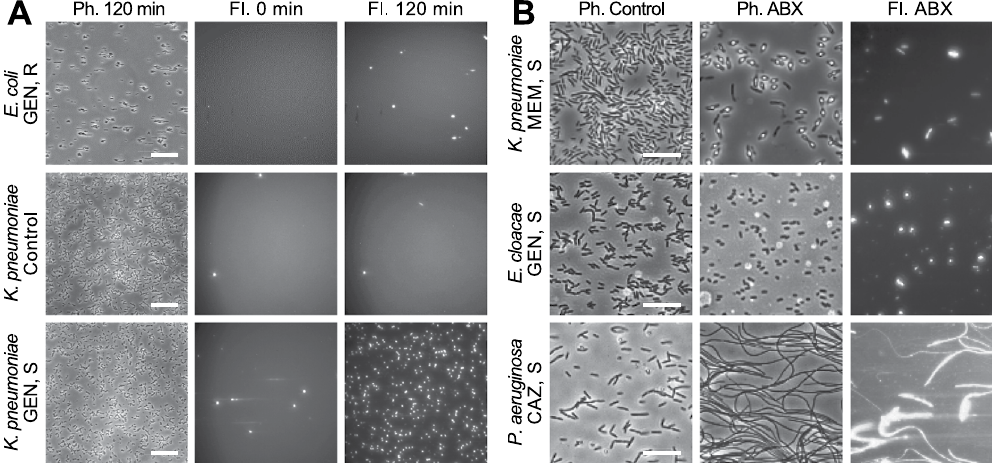
Figure 3. Representative responses to antibiotics of Gram-negative bacteria in our stress-based, microfluidic AST platform. ( A ) Fluorescence responses of GEN-susceptible ( K. pneumoniae 4453) and GEN-resistant strains ( E. coli 4456) in the presence (GEN, 2.5 µ g/mL) and absence (Control) of GEN. Scale bars are 50 µ m. ( B ) Morphological and fluorescence responses of susceptible strains to antibiotics within the flow-cell at t > 30 min. K. pneumoniae 426069 forms spheroplasts in the presence of 2 µ g/mL MEM, E. cloacae 331361 shrinks when exposed to 2.5 µ g/mL GEN, and P. aeruginosa 4480 fails to divide when breakpoint concentrations of CAZ are present (8 µ g/mL). Images are 1/6 of the original field of view. Scale bars are 20 µ m.